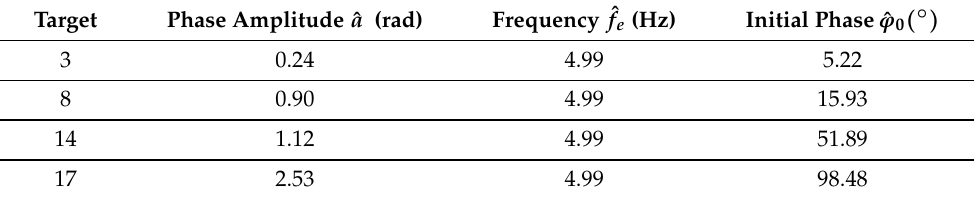
Table 3. Parameter estimation results of selected targets in the simulation